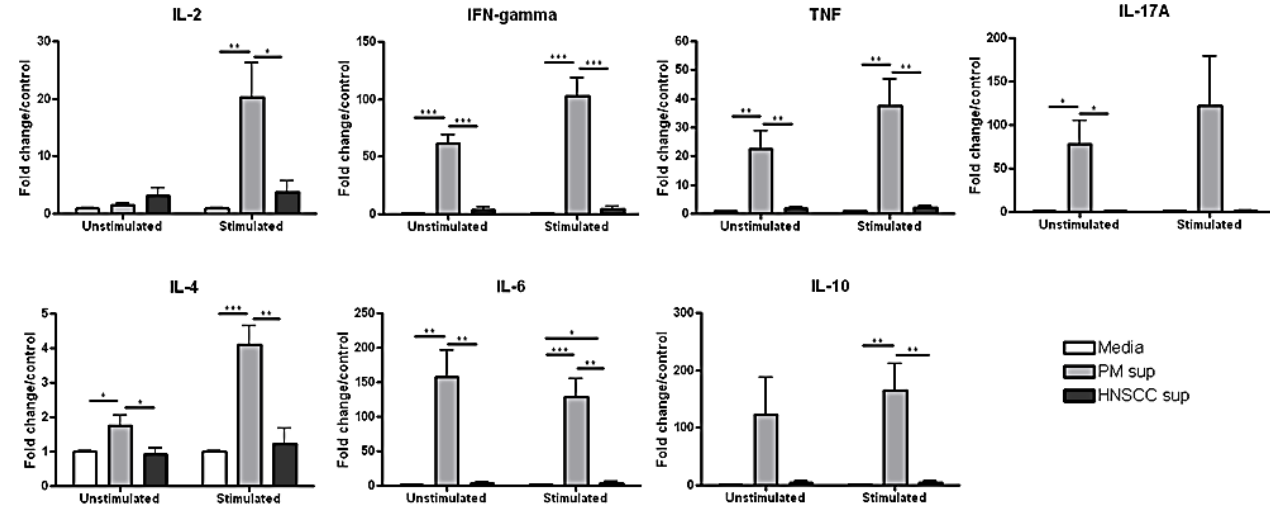
Figure 3. Splenocytes cultured with premalignant supernatant secrete significantly increased levels of Th1-, Th2-, and Th17-associated cytokines upon stimulation compared to splenocytes cultured with HNSCC supernatant or media alone. Splenocytes were incubated with media, premalignant cell-conditioned supernatant, or HNSCC cell-conditioned supernatant, respectively, and supernatant was collected for cytokine analysis after 72 h. Data shown represent 3 independent experiments performed in duplicate. * p < 0.05, ** p <